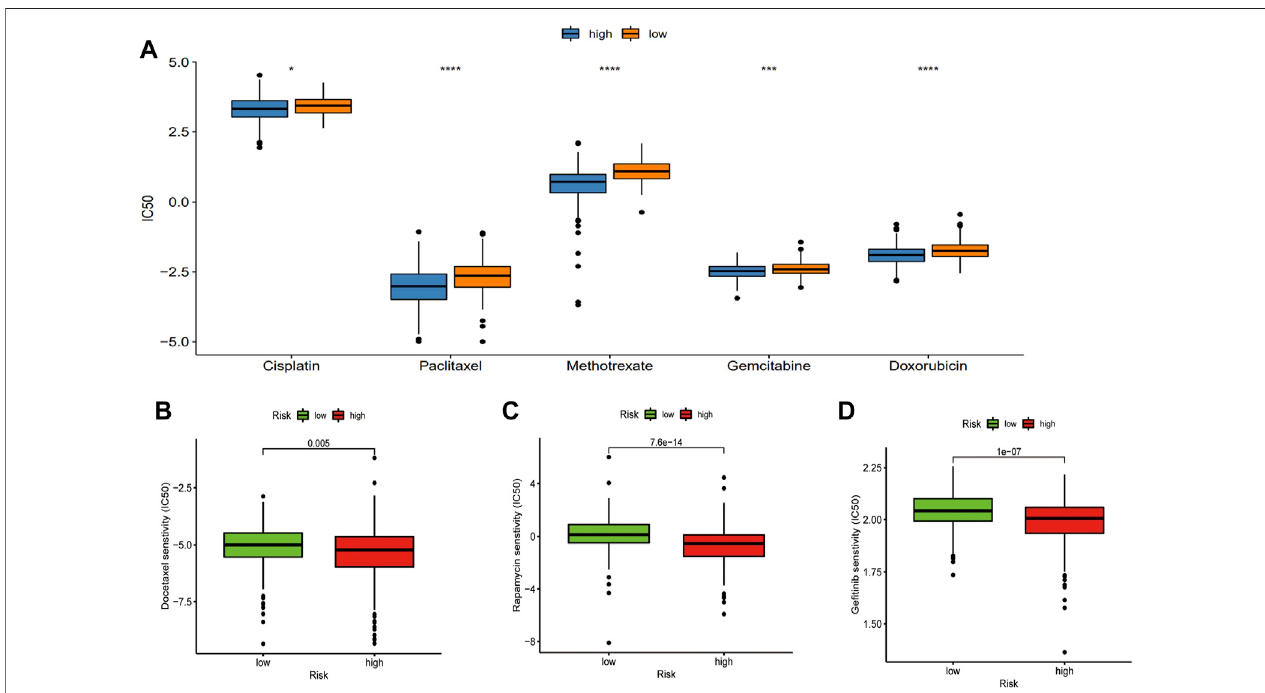
FIGURE8 | Relationship betweenclassic drugs and PRFs. (A) The IC50 ofCisplatin,Paclitaxel, Methotrexate, Gemcitabine, and Doxorubicin inthe high- and low- risk score groups. (B) The IC50 of Docetaxel in the high and low riskscore group. (C) The IC50 of Ge fi tinib in the high- and low-risk score groups. (D) The IC50 of Repamicin in the high- and low-risk score group (* p < 0.05, ** p < 0.01, *** p < 0.001, ns: no signi fi